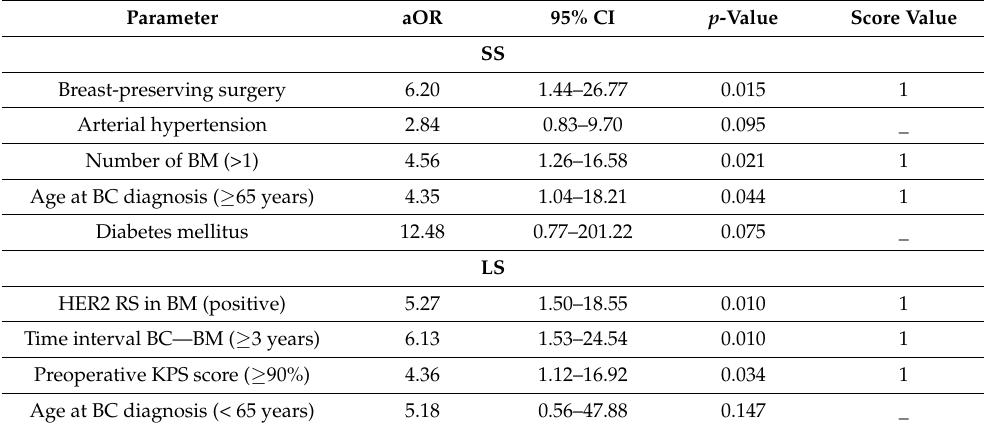
Table 2. Multivariate analysis for independent predictors of short (SS) and long survival (LS) after BCBM surgery.